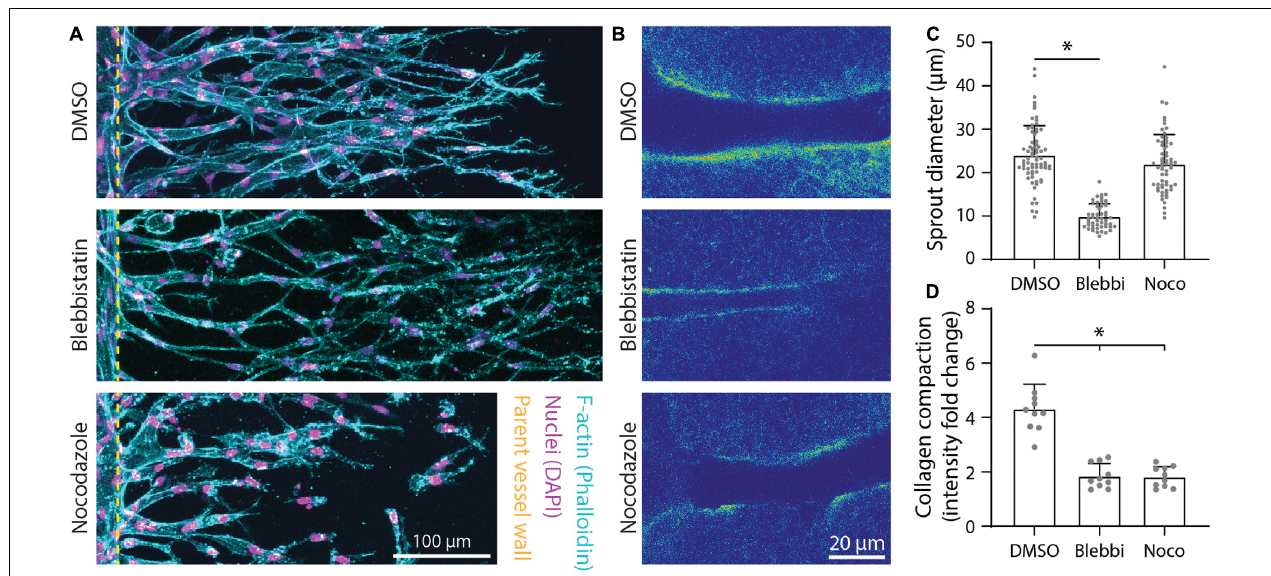
FIGURE 6 | Inhibition of actomyosin activity and microtubule polymerization reduces collagen compaction. (A) Representative images (max intensity projections) of dimethylsulfoxide (DMSO) control, 25 µ M blebbistatin-, and 50 ng ml − 1 nocodazole-treated sprouts cultured over 5 days with 250 nM sphingosine 1-phosphate (S1P) and 25 ng ml − 1 phorbol 12-myristate 13-acetate (PMA) within 3 mg ml − 1 collagen. (B) Representative images (individual z-slices) of fluorescently labeled collagen (intensity heat map) of conditions from panel (A) . (C,D) Quantifications of sprout diameter and collagen compaction from conditions in panels (A,B) . For sprout diameter: n ≥ 52 per condition and for collagen compaction: n ≥ 10 per condition. All data presented as mean ± SD; *indicates a statistically significant comparison to DMSO control with P < 0.05 (two-tailed Student’s t